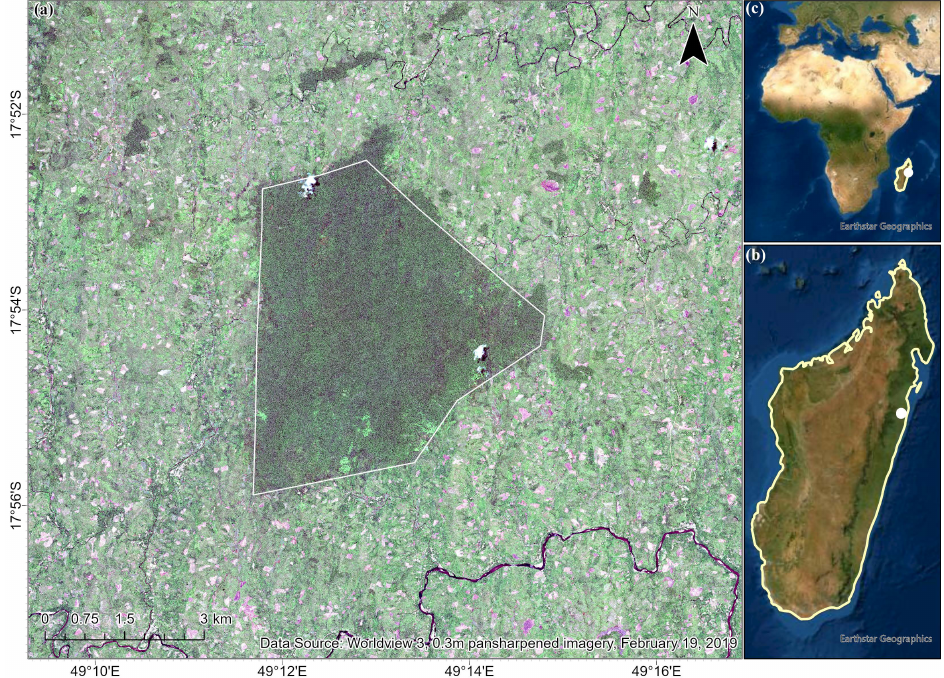
Figure 1. ( a ) WorldView-3 0.3 m pansharpened RGB imagery with minimal cloud cover, over the study area—the Betampona Nature Reserve (BNR) (white boundary polygon), located on the ( b ) eastern coast of Madagascar, which is ( c ) an island to the southeast of